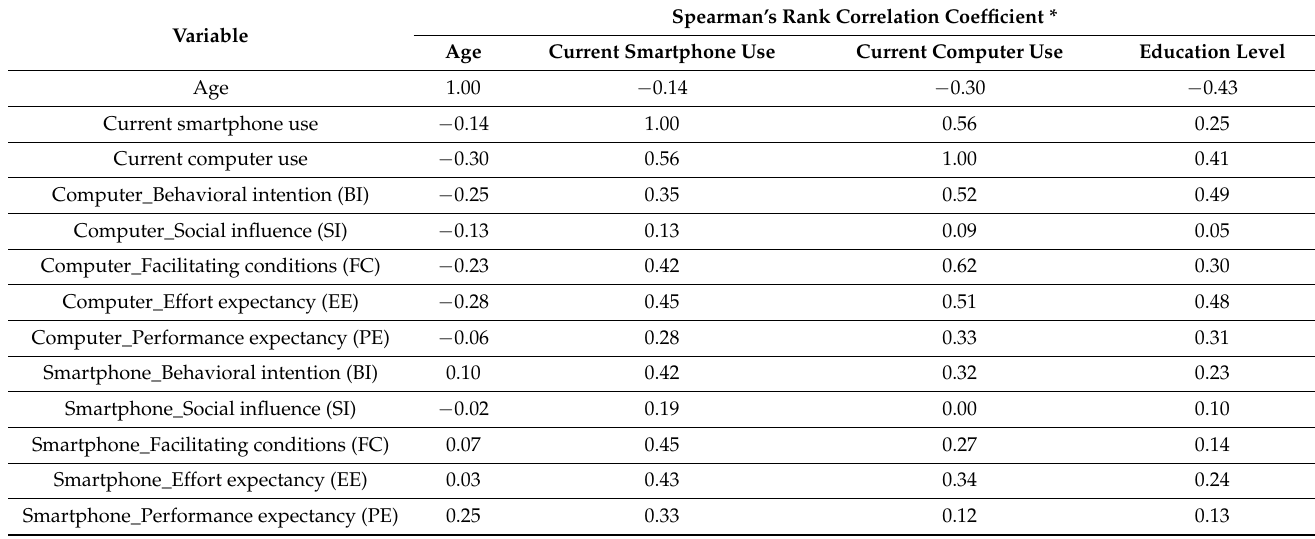
Table 1. The correlation between age, education level, current technology use, and technology use acceptance (Spearman’s rank correlation coefficient).